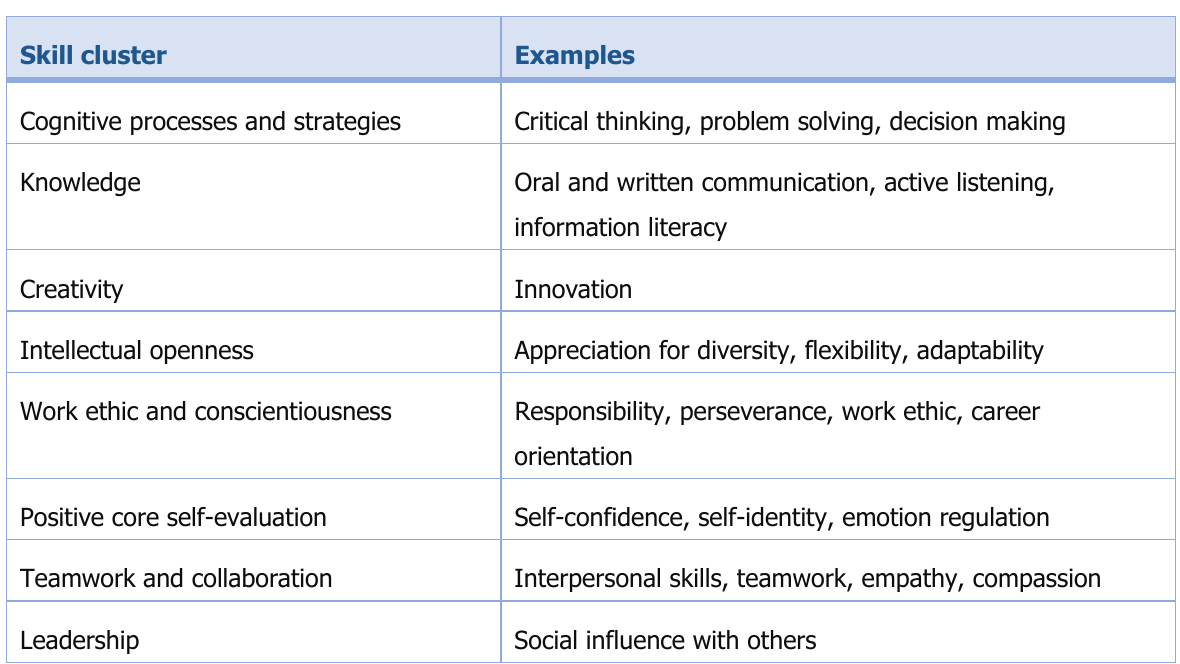
Table 1. Skill Clusters for Academic and Workplace Readiness 1 (adapted from National Research Council,